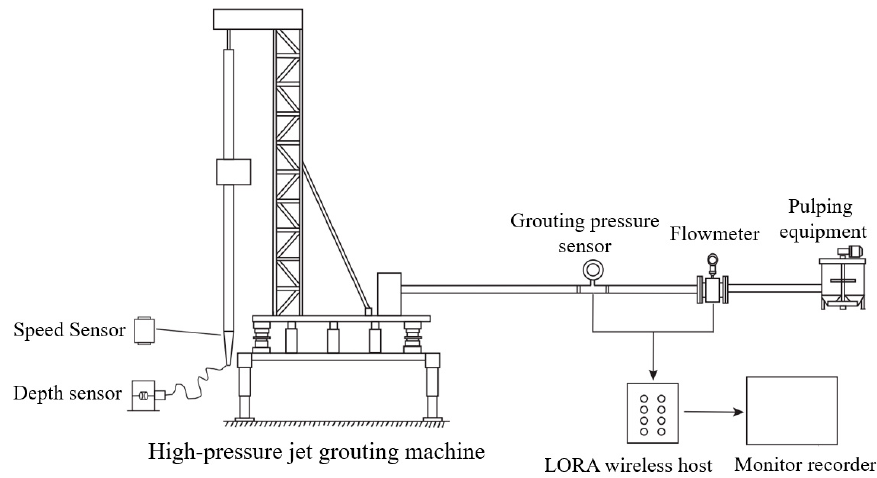
Figure 12. Framework of the information monitoring system of jet grouting.